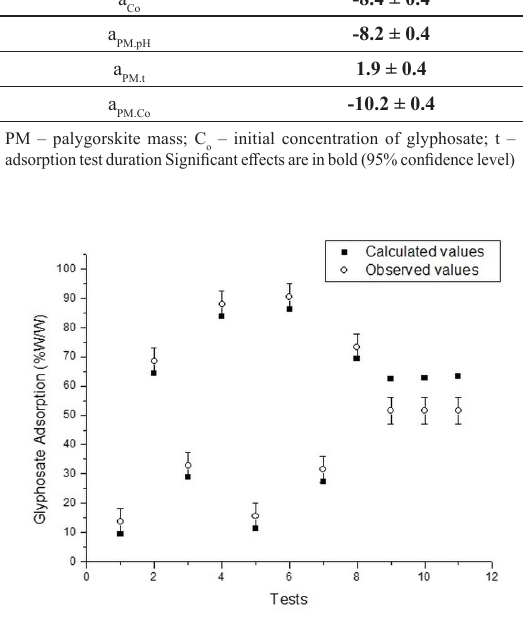
Figure 2. Calculated and observed glyphosate adsorption values using the empirical model (Equation 4). Error bars are confidence intervals calculated using Student’s distribution with three replicas at center point and confidence level of